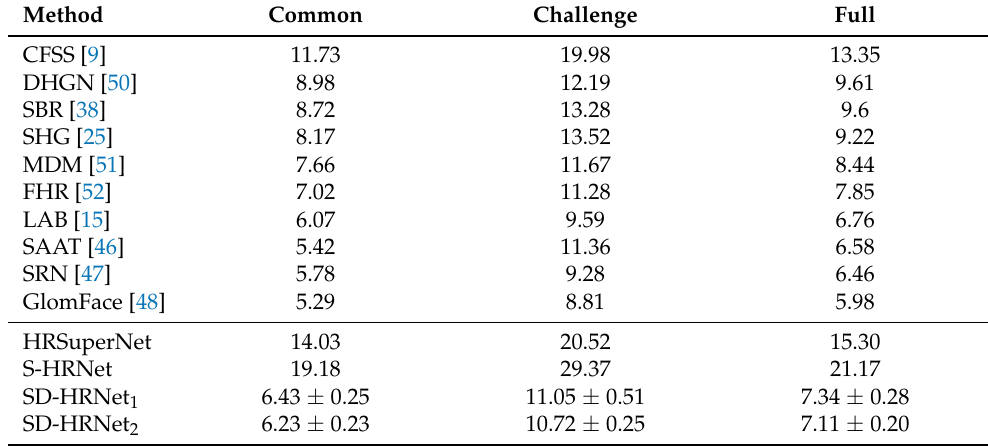
Table 3. Comparison of NME (%) on Masked 300W: common subset, challenge subset, and full set. Method